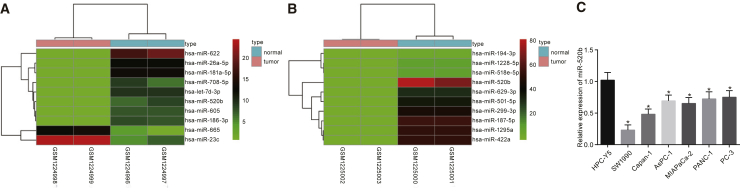
Low Expression of miR-520b Is Observed in PC(A and B) The heatmap of differentially expressed miRNAs in the PC serum sample from GEO: GSE50632 (A) and the heatmap of key miRNAs in exosomes from GEO: GSE50632 (B) (the x axis represented the sample number; the y axis represented the name of differentially expressed miRNAs). The histogram in the upper right was the color gradation, with the changed color from top to bottom in which each of the rectangles corresponds with an expression pattern value of a sample, and each line showed the expression pattern of all genes. The dendrogram in the left displayed the cluster analysis results of differentially expressed miRNAs from different samples. The top bar showed the sample type. In the upper-right color gradation, blue represented normal control sample, and red displayed the tumor sample. (C) qRT-PCR showed that the lowest expression pattern of miR-520b was observed in SW1990 among 6 examined PC cell lines (SW1990, Capan-1, AsPC-1, MIAPaCa-2, PANC-1, and PC-3) relative to HPC-Y5 cells. *p < 0.05 versus HPC-Y5. Data in the figure were measurement data, which were expressed as mean ± standard deviation and compared by one-way ANOVA; the experiment was repeated 3 times independently.